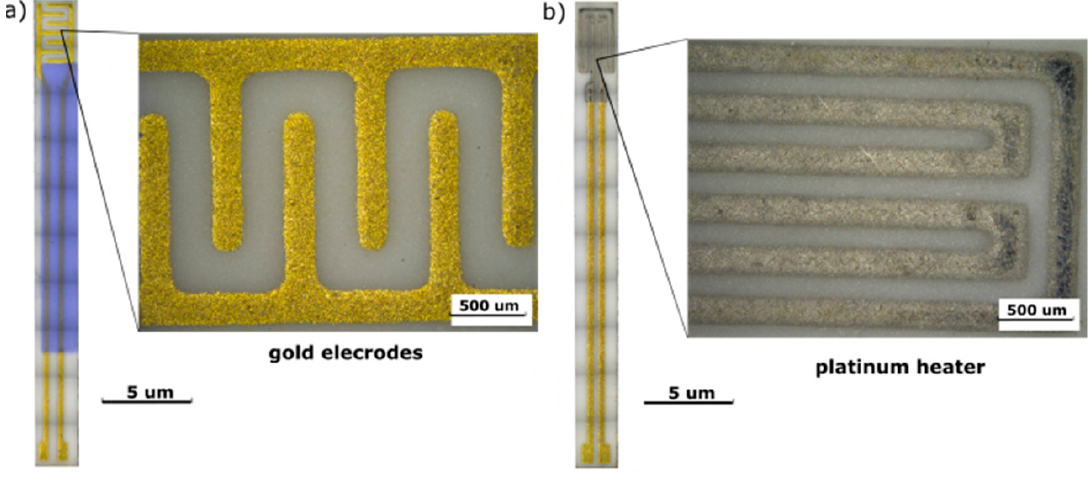
Figure 1. Images of the gas sensor surface from the side of: ( a ) gold electrodes and ( b ) platinum